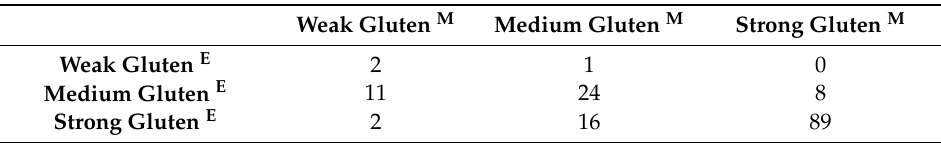
Table 7. Rough classification monitoring results (n =